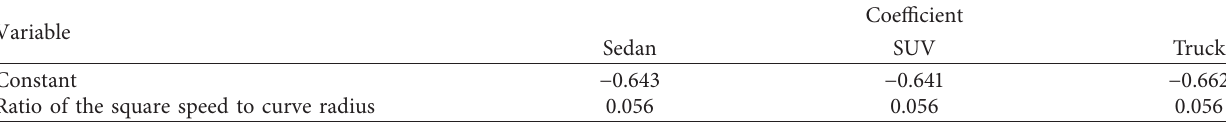
Table 1: Coefficients of the statistical model of the maximum lateral acceleration in the simple horizontal curve for various vehicles.